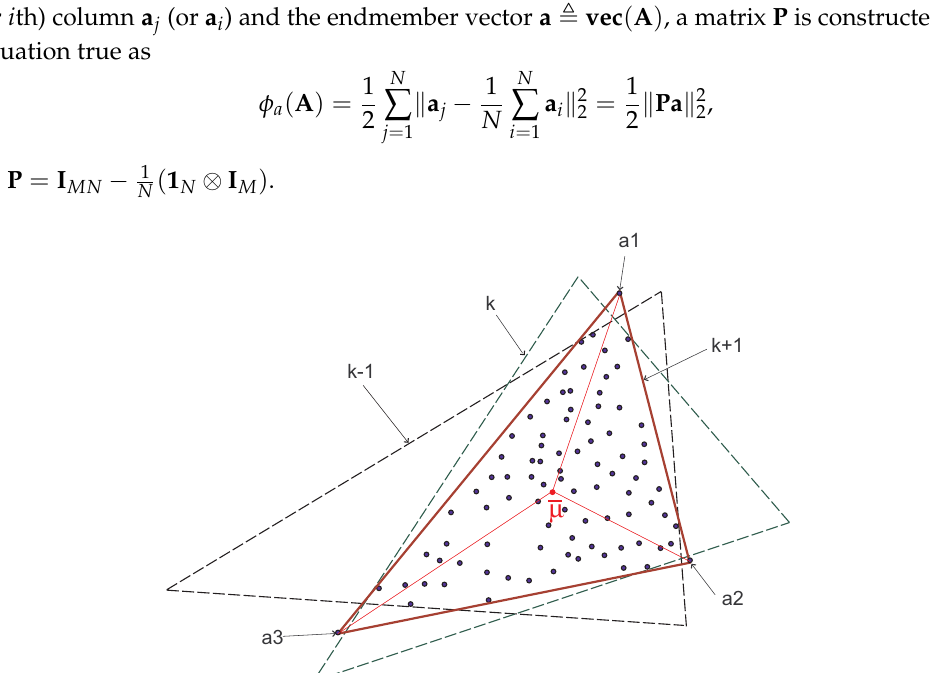
Figure 2. Schematic diagram of the minimum-volume simplex with three vertices or endmembers a 1 , a 2 and a 3